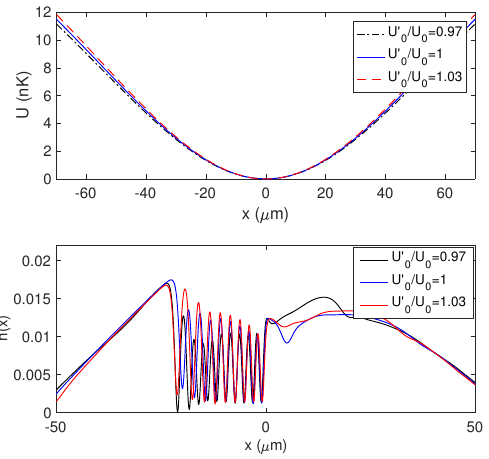
( x ) . Solid blue: U (cid:48) 1D / U = 1.03. Note that the minimum of U ( x ) is shifted to 0 0